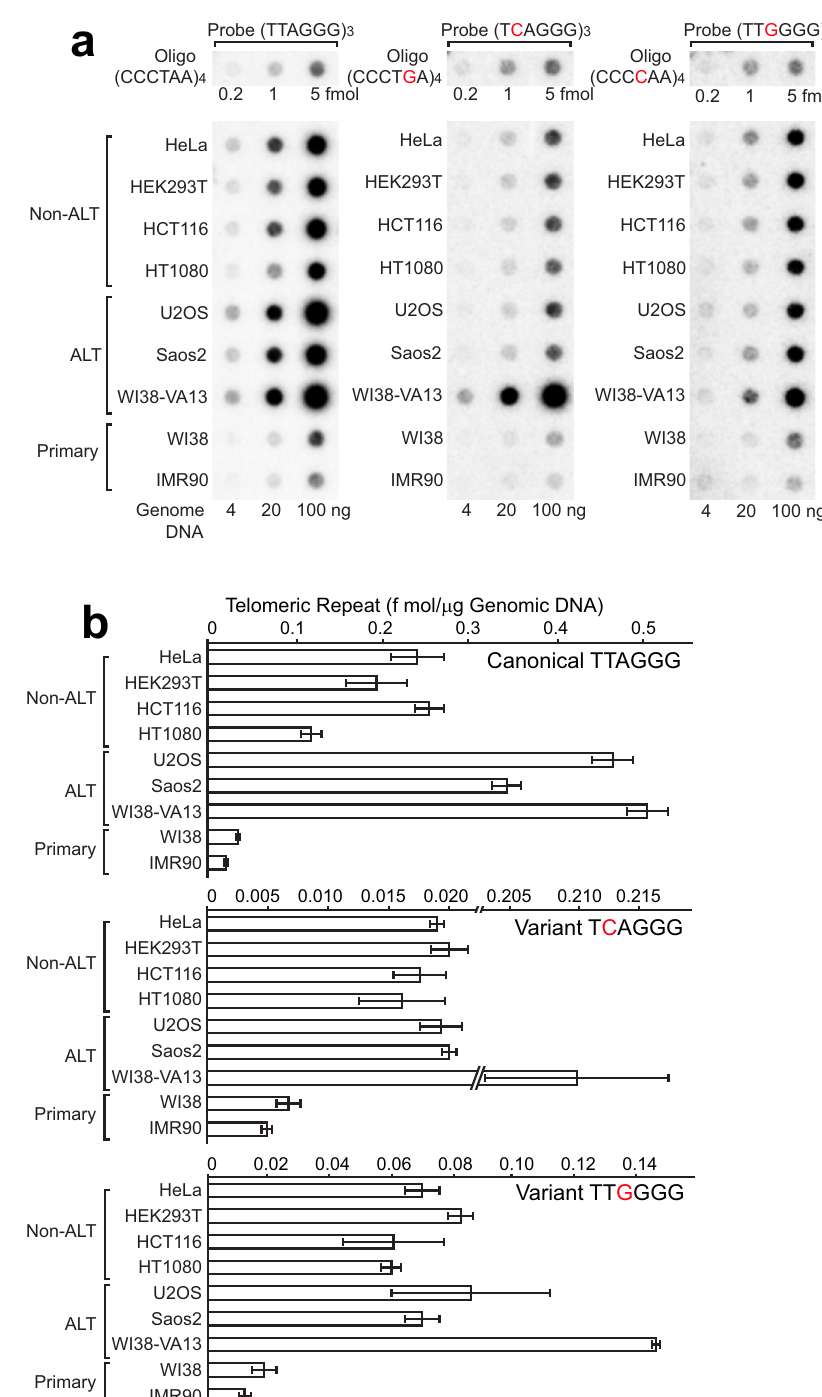
Fig. 5 Detection of telomeric variant repeats in ALT-positive and non-ALT cancer cell lines. a Dot blot hybridization analysis for genomic DNA samples was conducted using three separate telomeric repeat probes capable of distinguishing a single-nucleotide mismatch (Supplementary Fig. 4a, b). In addition to canonical TTAGGG signals, varying amounts of TCAGGG and TTGGGG variant repeat signals were detected in both ALT and non-ALT cancer cell lines, but not in primary human fi broblast cells. b Quantitation of canonical and variant telomeric repeats was done by comparing dot blot signals of genomic DNA and canonical and variant repeat-speci fi c control oligos. Three independent dot blot hybridization analyses were performed. Data are mean ± SD ( n = 3, biological replicates). All individual experimental data values are presented in Source Data fi 8c, left). In contrast, we found that digestion by RNase H2 is very A – C-mismatched base pairs are replaced with matched I:C sensitive to the presence of A – C-mismatched base pairs. The base pairs, the RNA:DNA hybrids became more permissive to RNA strand of the RNA:DNA hybrids containing six RNase H2-mediated digestion (Fig. 8c, right): more ef fi cient A – C-mismatched base pairs was almost completely resistant to digestion for hybrids with more I:C-matched base pairs (Fig. 8d digestion by RNase H2 (Fig. 8b, lower panels and 8c, right). As and Supplementary Fig. 8).